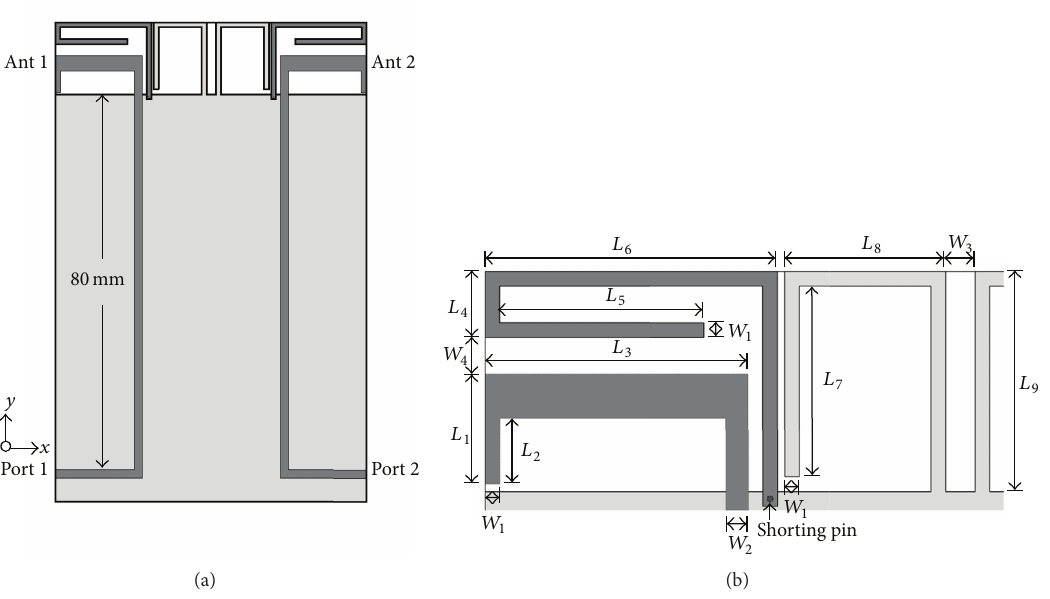
Figure 1: Geometry of the proposed antenna: (a) overall view and (b) detailed